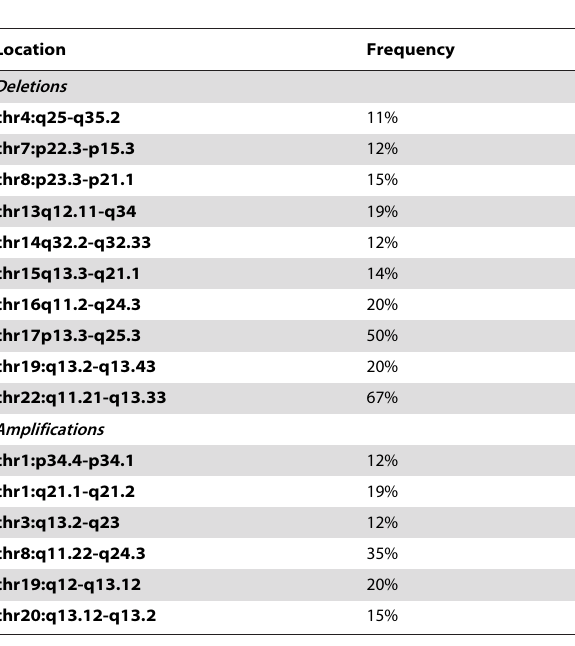
Table 1. Chromosomal deletions and amplifications in ovarian cancer